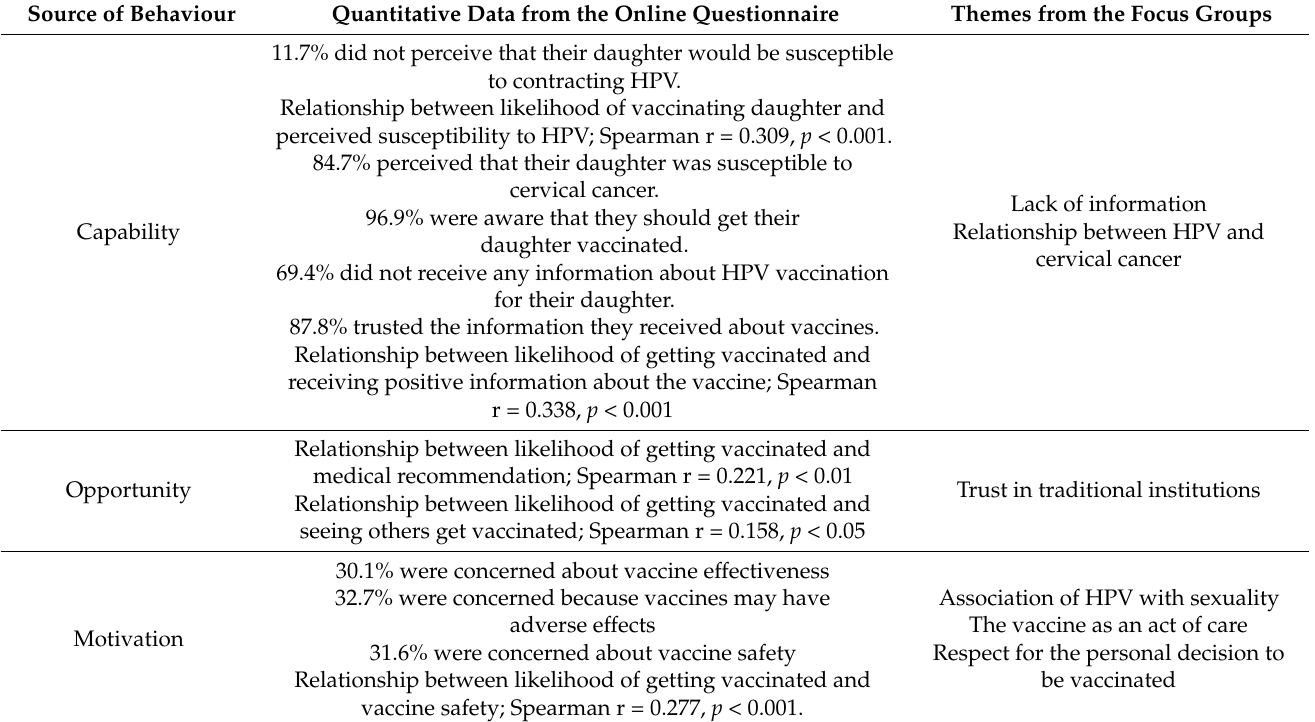
Table 3. A joint display of factors influencing HPV-vaccine hesitancy to parents/caregivers and daughters based on the COM-B